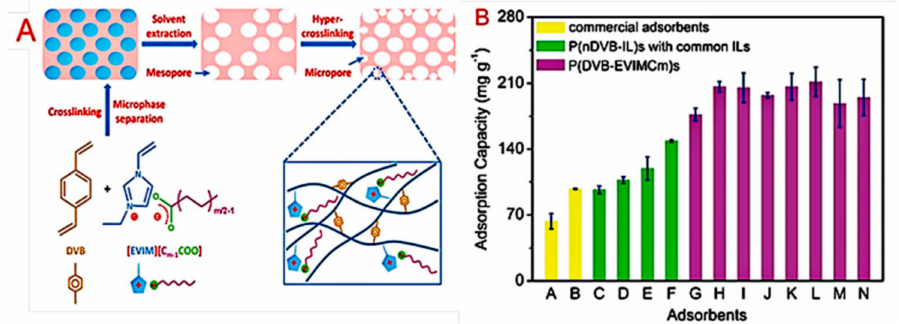
Figure 9. Synthetic route for mesoporous PILs and hypercrosslinked mesoporous PILs ( A ) and their adsorption capacity for mixed tocopherols ( B ) [84]. Reprinted with permission from Royal Society of